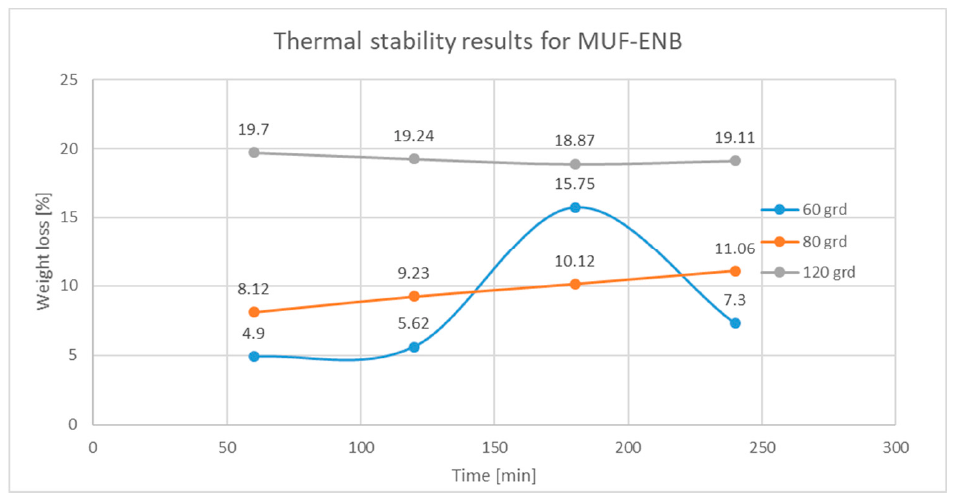
Figure 21. Weight loss variation over time for PUF-DCPD after thermal exposure at 60, 80, and 120 °C.